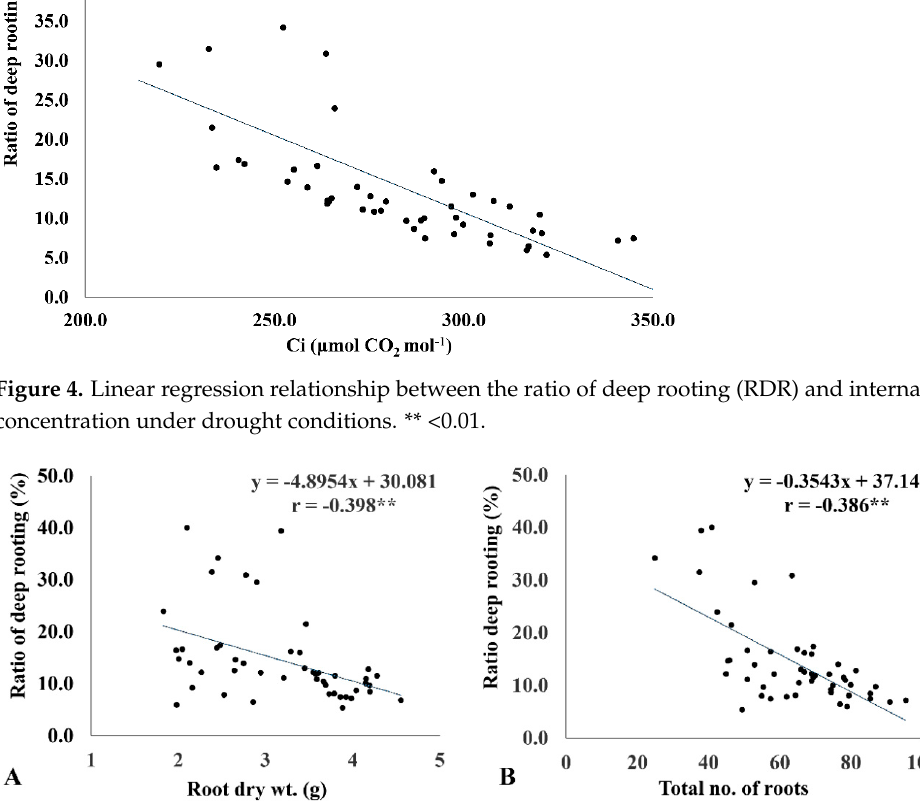
Figure 5. Linear regression relationship between the ratio of deep rooting (RDR) and root dry weight (RDW) ( A ) and the total number of roots (RN) ( B ) under drought conditions. ** <0.01.